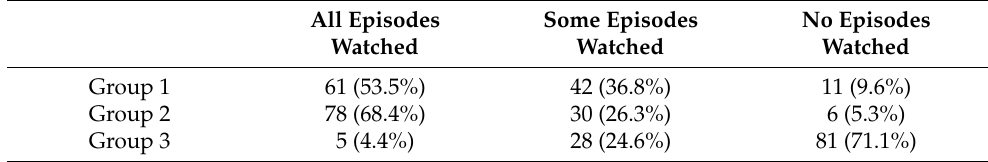
Table 2. Episodes Children Watched (n = 114 per group; percentage reported per group).